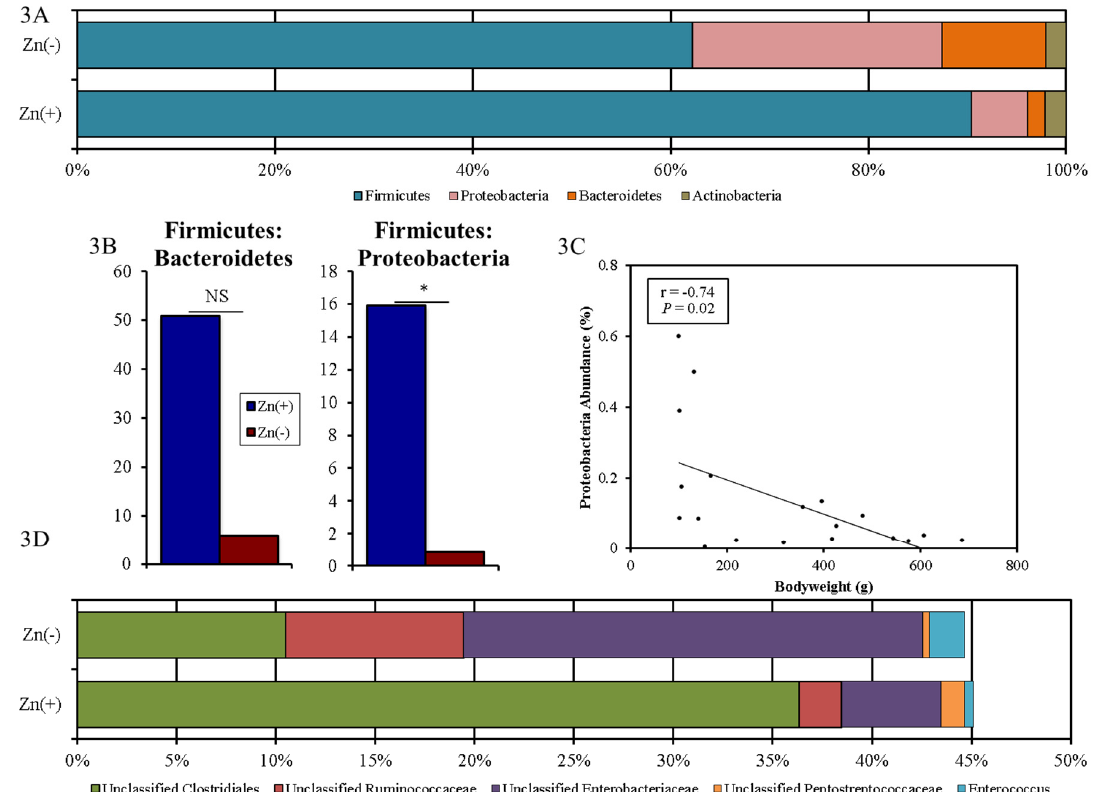
Figure 3. Phylum ‐ and genera ‐ level cecal microbiota shifts due to dietary Zn depletion. ( A ) Phylum ‐ level changes between the Zn(+) and Zn( − ) groups as measured at the end of the study (day 28). Only those phyla with abundance > 1% are shown; ( B ) Increased Firmicutes to Bacteroidetes and Proteobacteria ratios in the Zn(+) group (* p < 0.05, NS = not statistically significant); ( C ) Inverse correlation between Proteobacteria abundance and bodyweight; ( D ) Genus ‐ level changes in the Zn(+) and Zn( − ) group as measured at the end of the study (day 28). Only those genera significantly different between groups are shown.